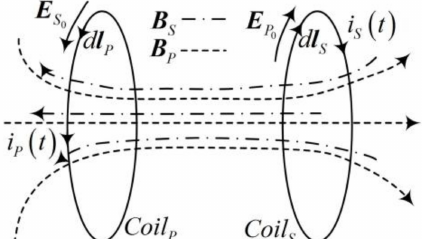
Figure 3. Schematic of field distribution around the primary and secondary